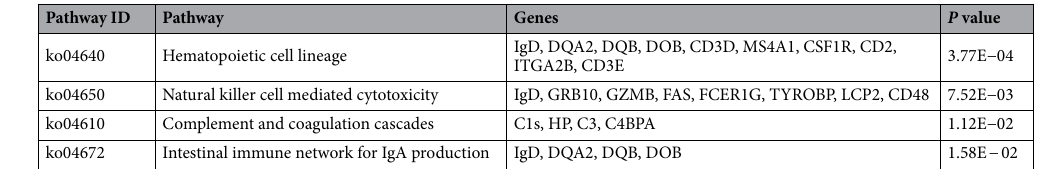
Table 3. Significantly enriched pathways of DEGs associated with immune